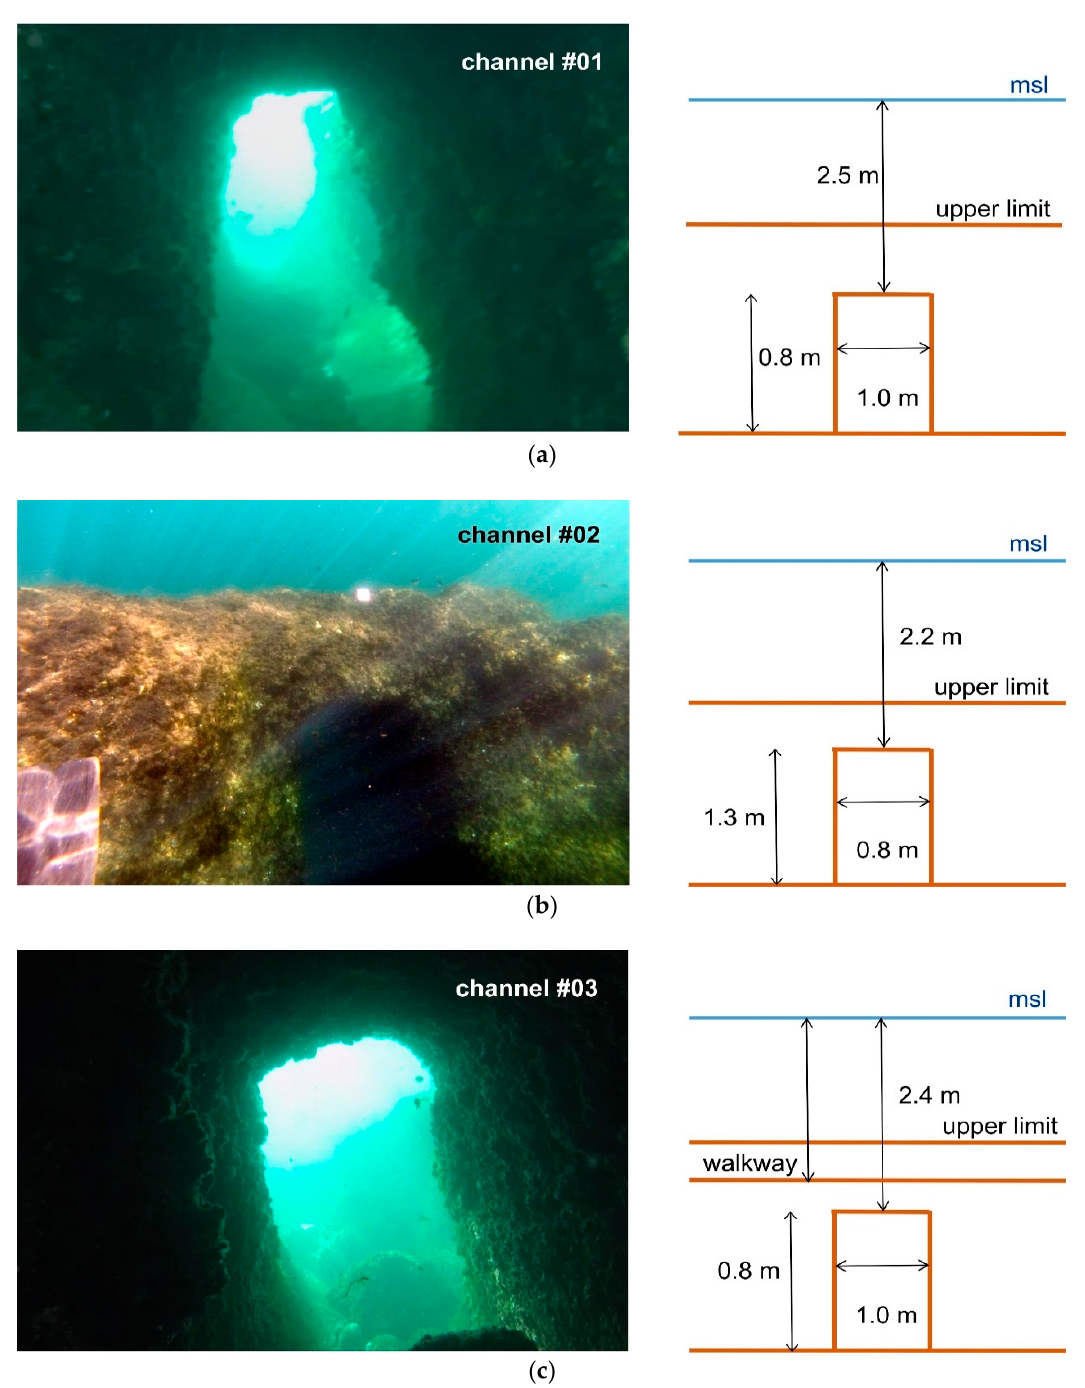
Figure 14. Measurements of the channel dimensions and submersion: ( a ) channel #01; ( b ) channel #02; ( c) channel